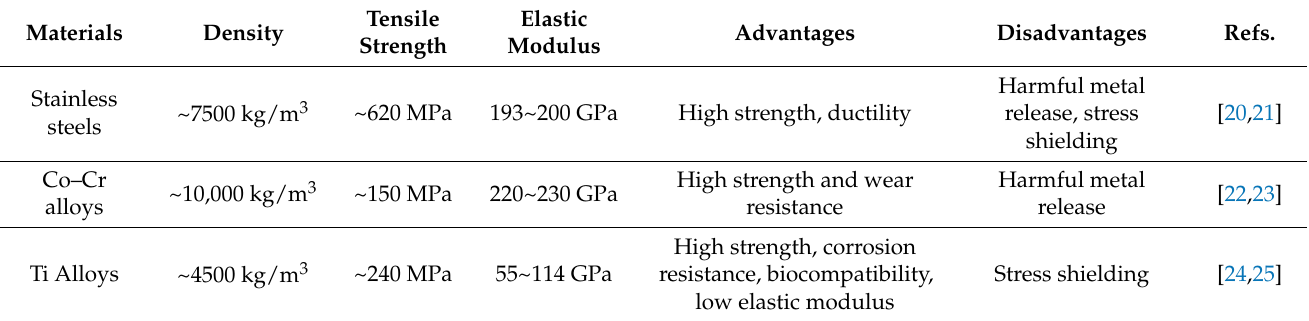
Table 1. Summary of the properties, advantages, and disadvantages of the most common biomedical